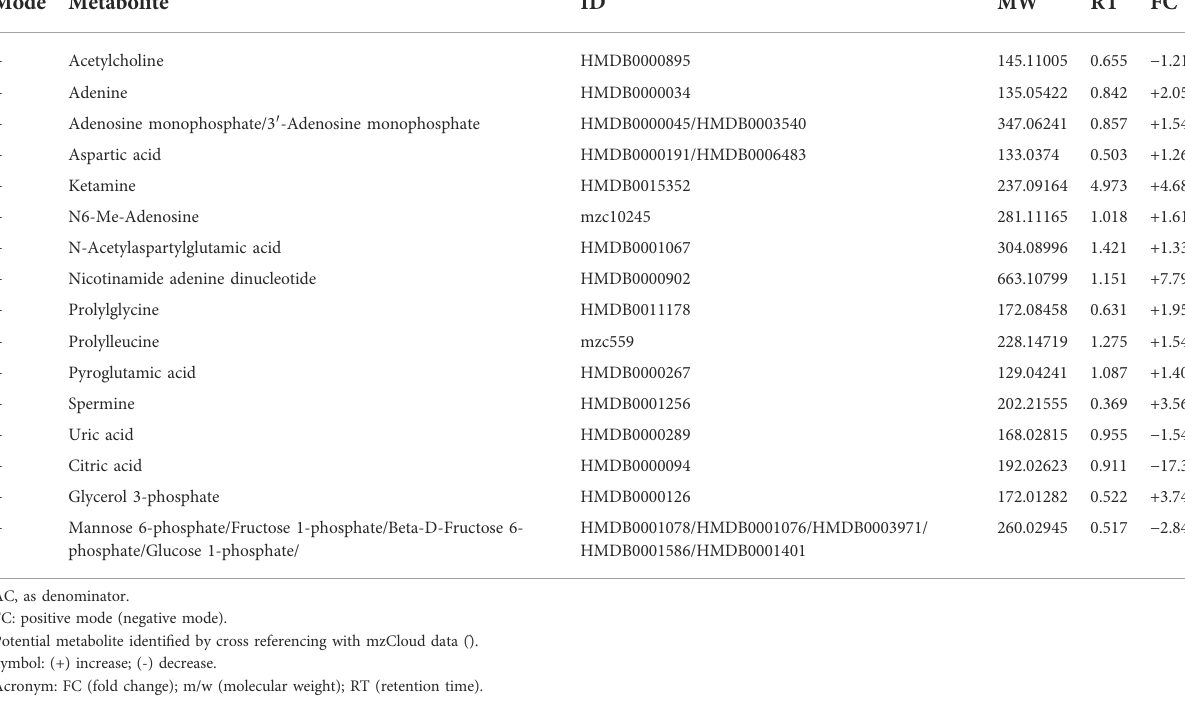
TABLE 5 List of metabolites in AT against AC.